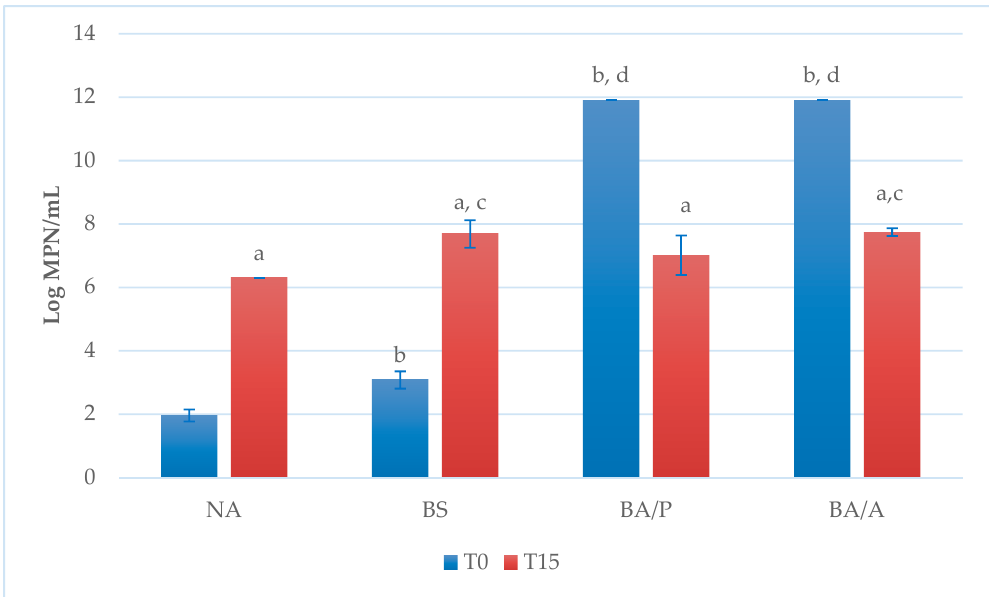
Figure 4. Abundance of hydrocarbon degrading bacteria, evaluated by the most-probable number (MPN) method, at the beginning (T0) and after 15 days (T15) of the microcosm experiment (mean values, standard deviations, n = 3) for the different treatments: natural attenuation (NA), biostimulation (BS), bioaugmentation with inoculum pre-grown in petroleum (BA/P) and bioaugmentation with inoculum pre-grown in acetate (BA/A). a—significant differences between T0 and T15; b—significant differences comparing all treatments with NA in T0; c—significant differences comparing all treatments with NA in T15; d—significant differences comparing BS with the BA treatments in